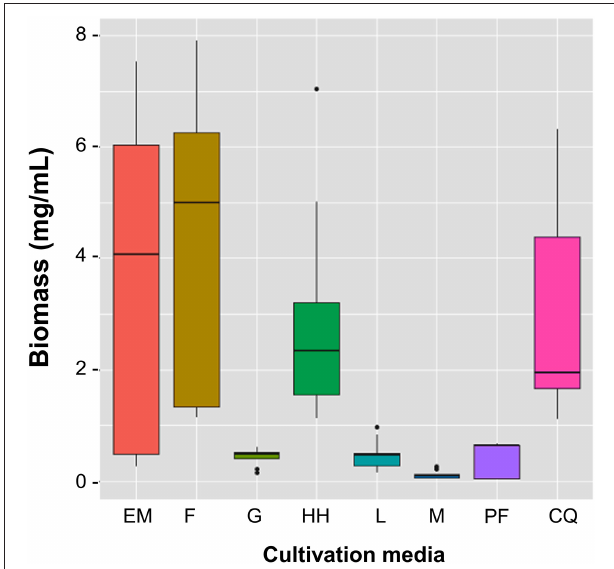
FIGURE 1 | Total biomass of B. bassiana produced in cultures containing Minimal Medium (M), minimal medium with simple carbon substrate (G, glucose; L, laminarin; CQ, colloidal chitin), and minimum medium with complex carbon substrate (EM, E. melanocampta powder; HH, H. hampei powder; F, F. oxyparum powder; PF, P. variabilis powder). The boxes display the central tendency and spread for each treatment. The horizontal line inside each box shows the median for each treatment. EM, F, and HH are associated with the highest biomass production. The CQ medium produces the greatest variability while M, G, L, and PF are associated with the lowest biomass production. The dots outside the boxes represent outliers. p < 0.05, n ≥ 3 independent